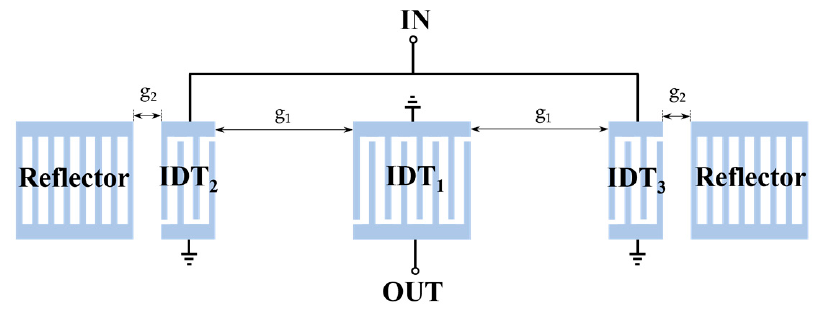
Figure 3. The schematic of a two-port SAWR with three IDTs.